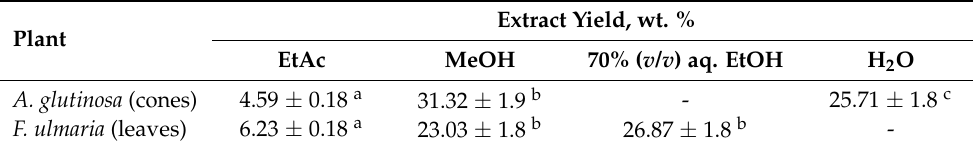
Extract Yield, wt.